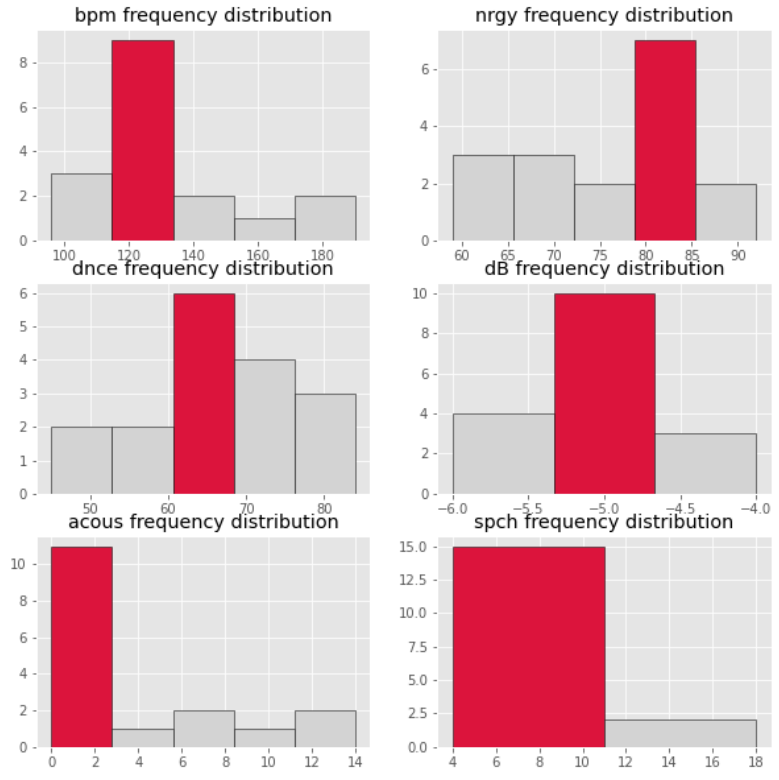
Figure 6. Histogram representing the frequency range of features used in Katy Perry’s